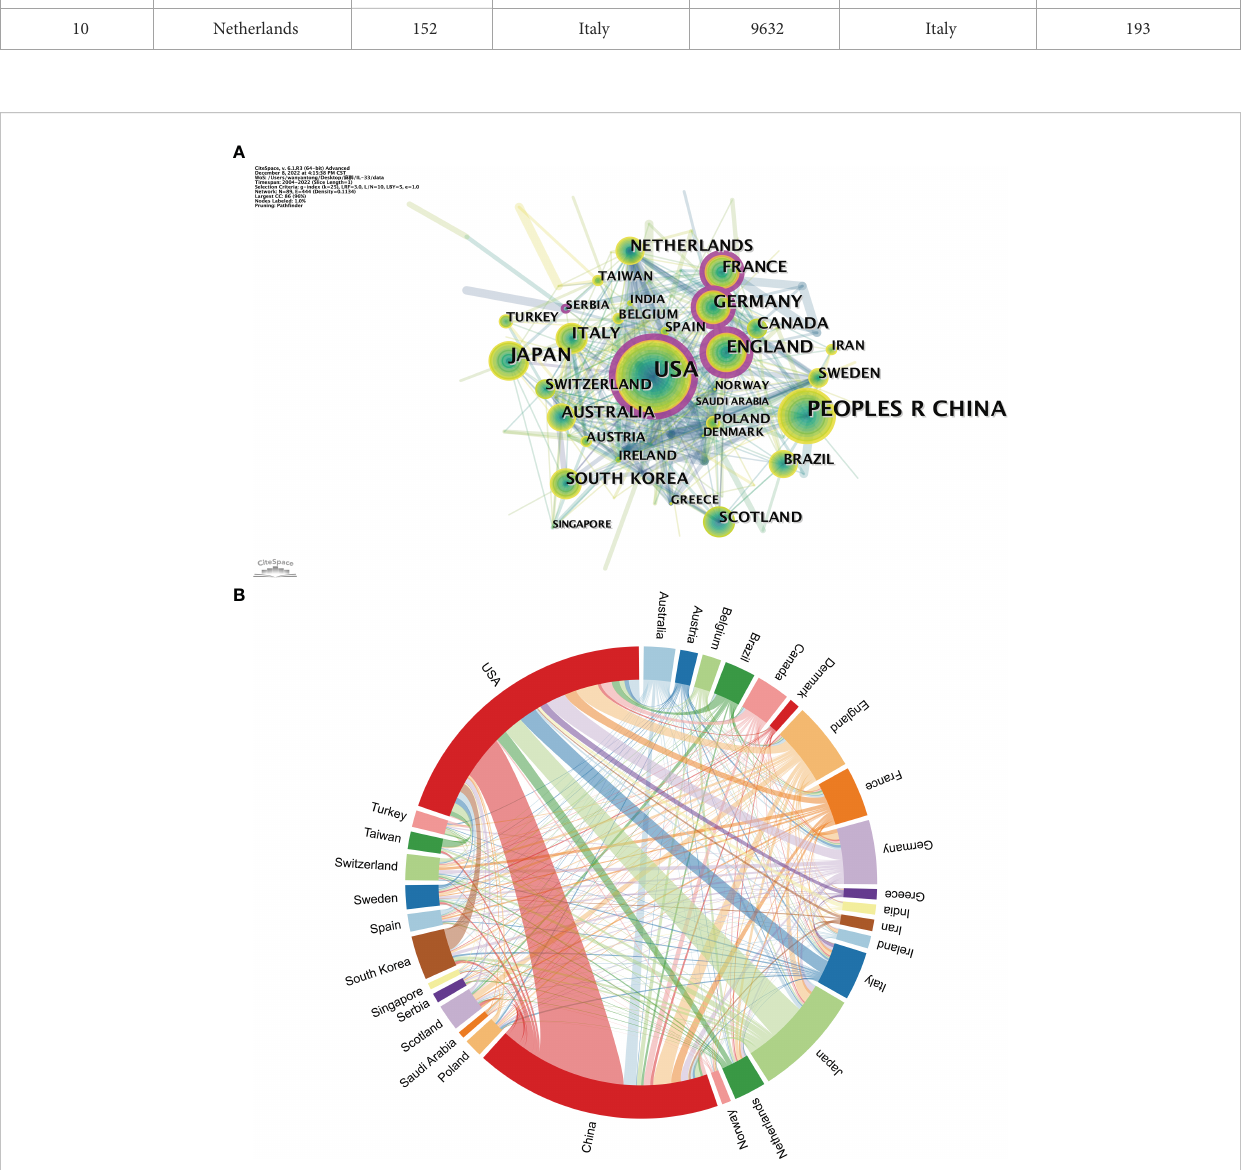
FIGURE 2 The analysis of countries related to IL-33. (A) The co-occurrence map of countries. The node size means the co-occurrence frequencies, while the linkages mean the co-occurrence relationships. Nodes with purple round mean high betweenness centrality ( ≥ 0.1). (B) The network map of cooperation between